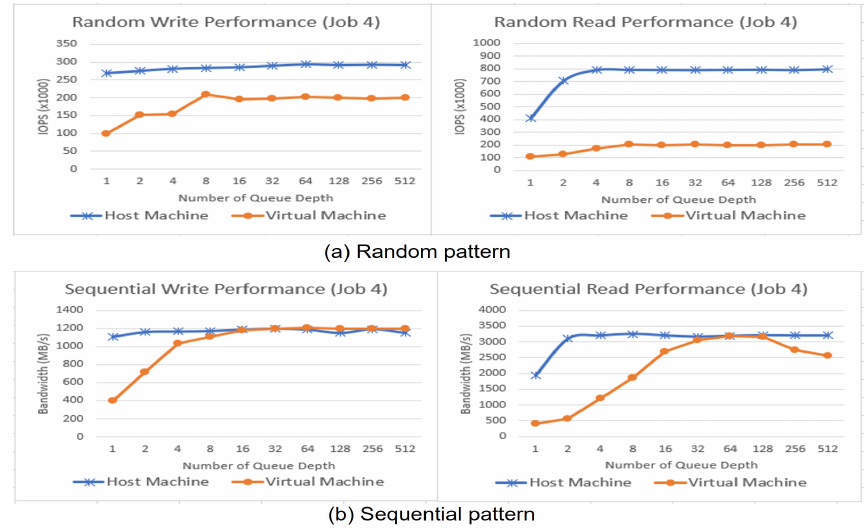
Figure 2. I/O virtualization overhead: Performance degradation is due to the duplicated I/O